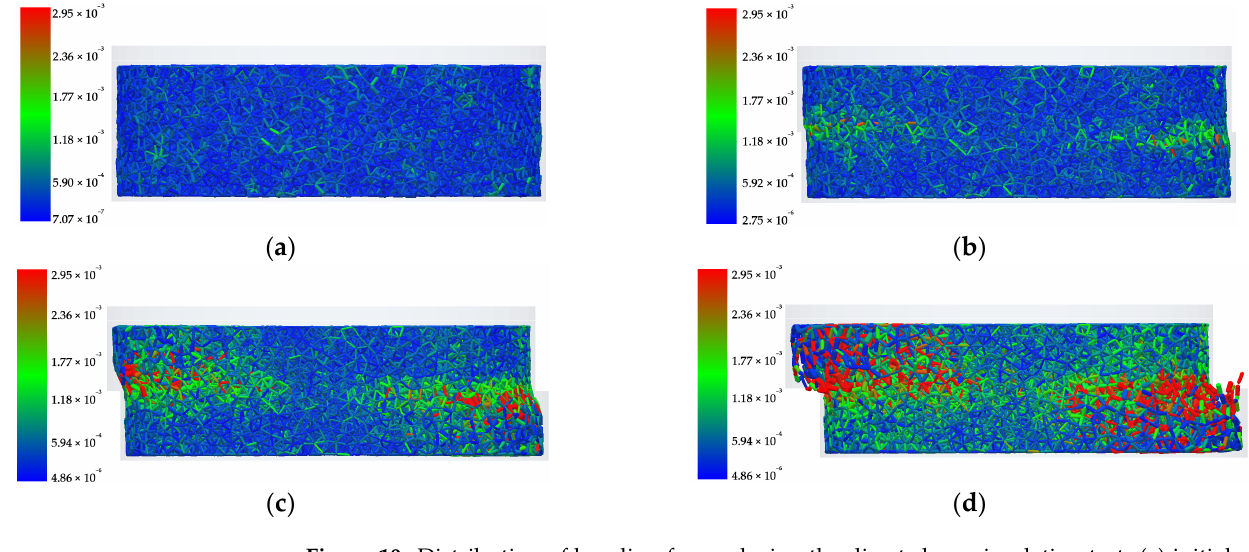
Figure 10. Distribution of bonding forces during the direct shear simulation test: ( a ) initial state; ( b ) start of cutting; ( c ) maximum stress; ( d ) end of shear.